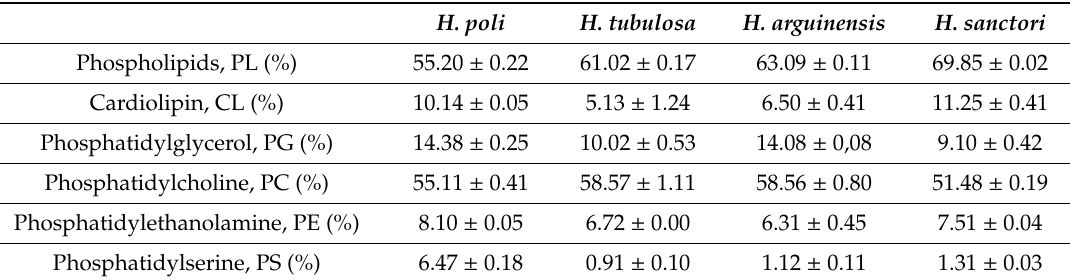
Phospholipids compositions of the studied sea cucumber after acetone purification. Mean ± SD [ n =